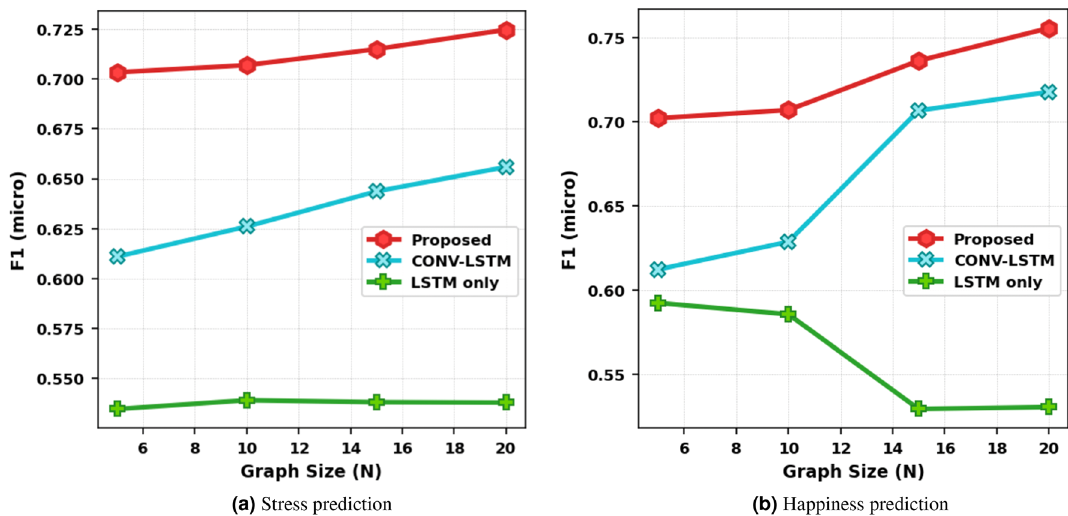
Figure 2. Impact of graph size on model prediction for fixed sequence length L = 5.